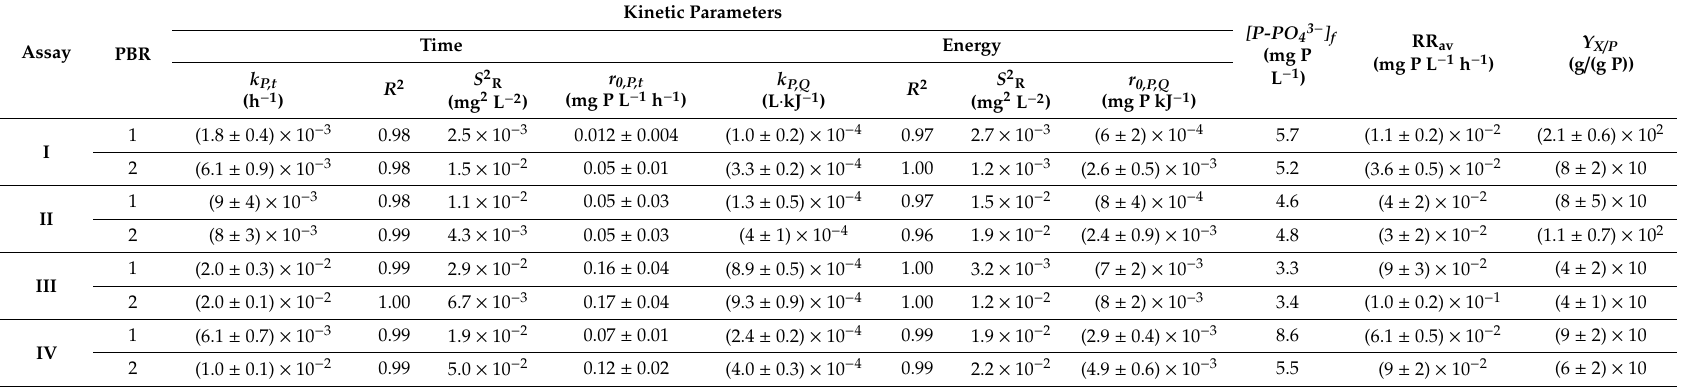
Table 4. Phosphorus removal kinetic parameters for all